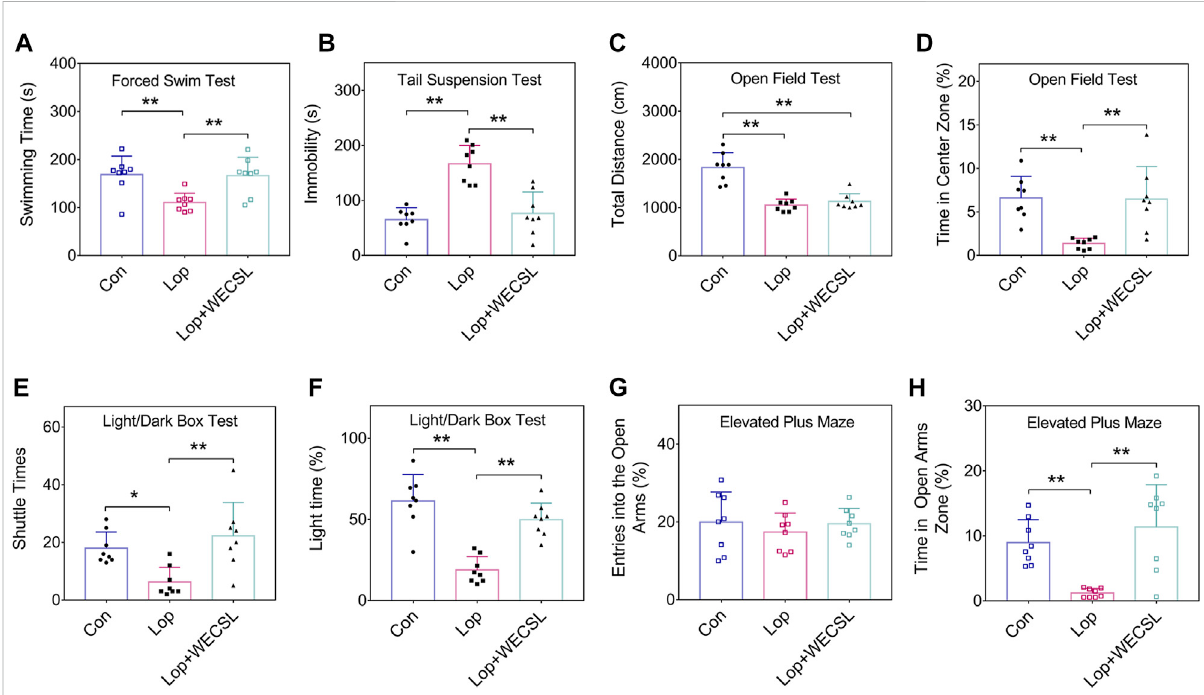
FIGURE 2 WECSL improved anxiety and depression behavioral in constipated mice. (A) Swimming time of mice in FST. (B) Immobility time of mice in TST. (C,D) The total distance traveled (C) and time stayed in the center zone (D) in the OFT. (E,F) Entries into the light chamber (E) and total time spent in the light chamber (F) in the LDBT. (G,H) Entries into open and closed arms (G) and the time spent in open arms (H) in the EPM. Data are presented as mean ± SD ( n = 8 per group). * p < 0.05, ** p <